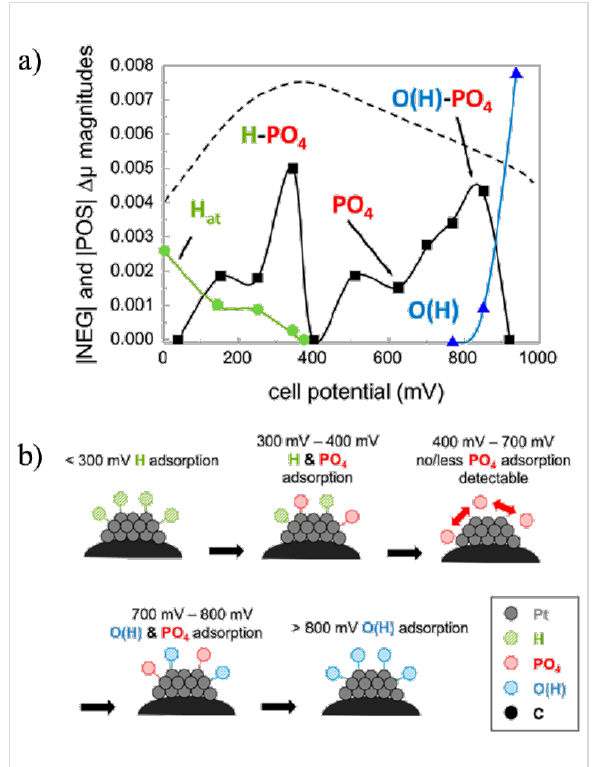
Figure 13: (a) Coverage of different adsorbates on platinum by analyzing |POS| and |NEG| Δμ amplitudes at various cell potentials. The dashed line indicates the expected PO 43 − coverage according to He et al. [64]. (b) Illustration of adsorbates on platinum at different cell voltages. Reproduced with permission from [63]. Copyright 2013 American Chemical